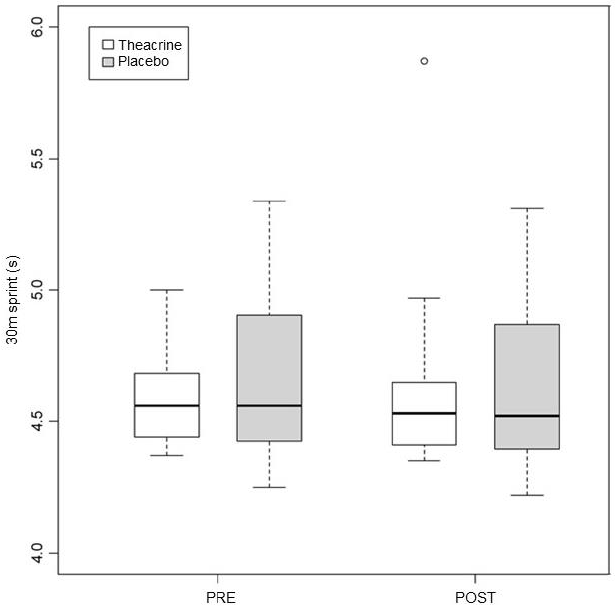
Figure 4. Alterations in performance in the 30 m sprint in the first and second assessments. Values expressed in median – interquartile interval. s =